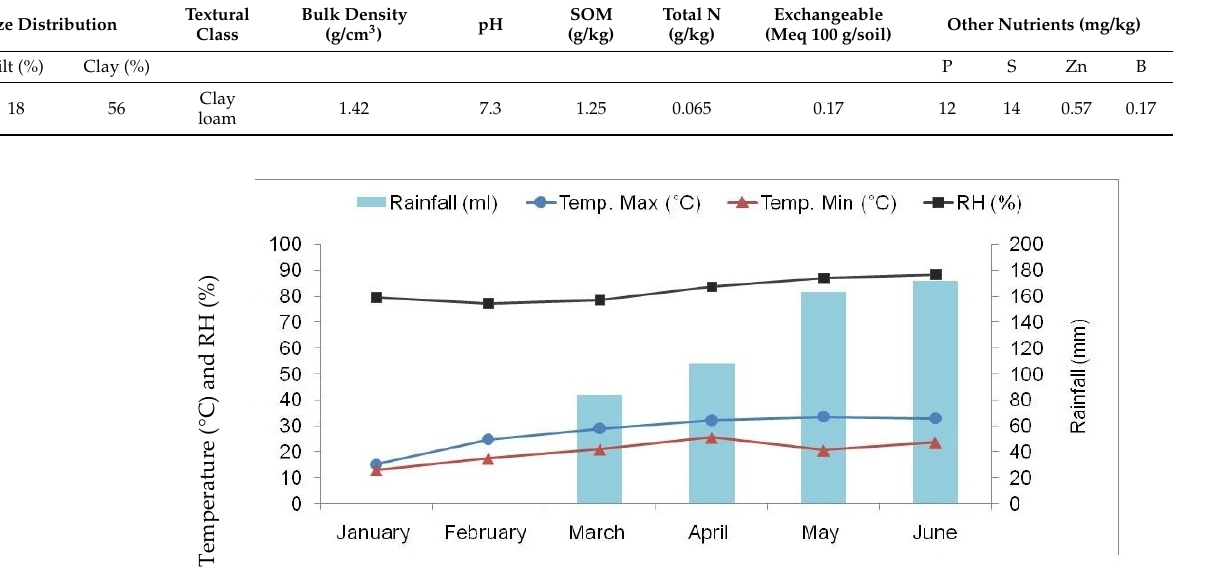
Figure 1. Monthly average maximum and minimum temperature (°C), relative humidity [RH (%)], and total rainfall prevailed during 2015. Temp.—temperature, Max—maximum, Min—minimum.